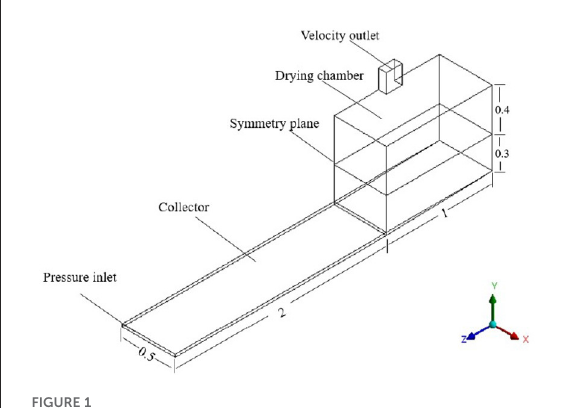
FIGURE1 Computational domain (with symmetry plane) of the geometry of the solar dryer (dimensions in m) with a capacity to cure 150kg of onions. A fan is positioned at the velocity outlet drafting heated air up through the drying chamber from an inclined plenum attached to the collector